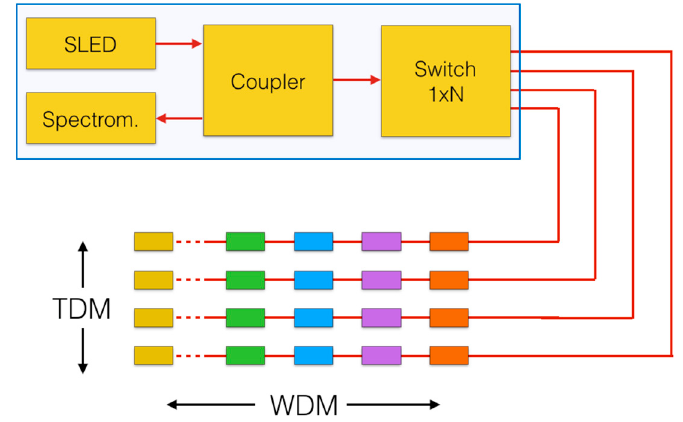
Figure 2. Schematic of white-light interrogation system for FBG sensor networks. Red lines show optical connections; the blue box includes all the building blocks of the interrogator. Colored sensors refer to FBG arrays (one wavelength per color).